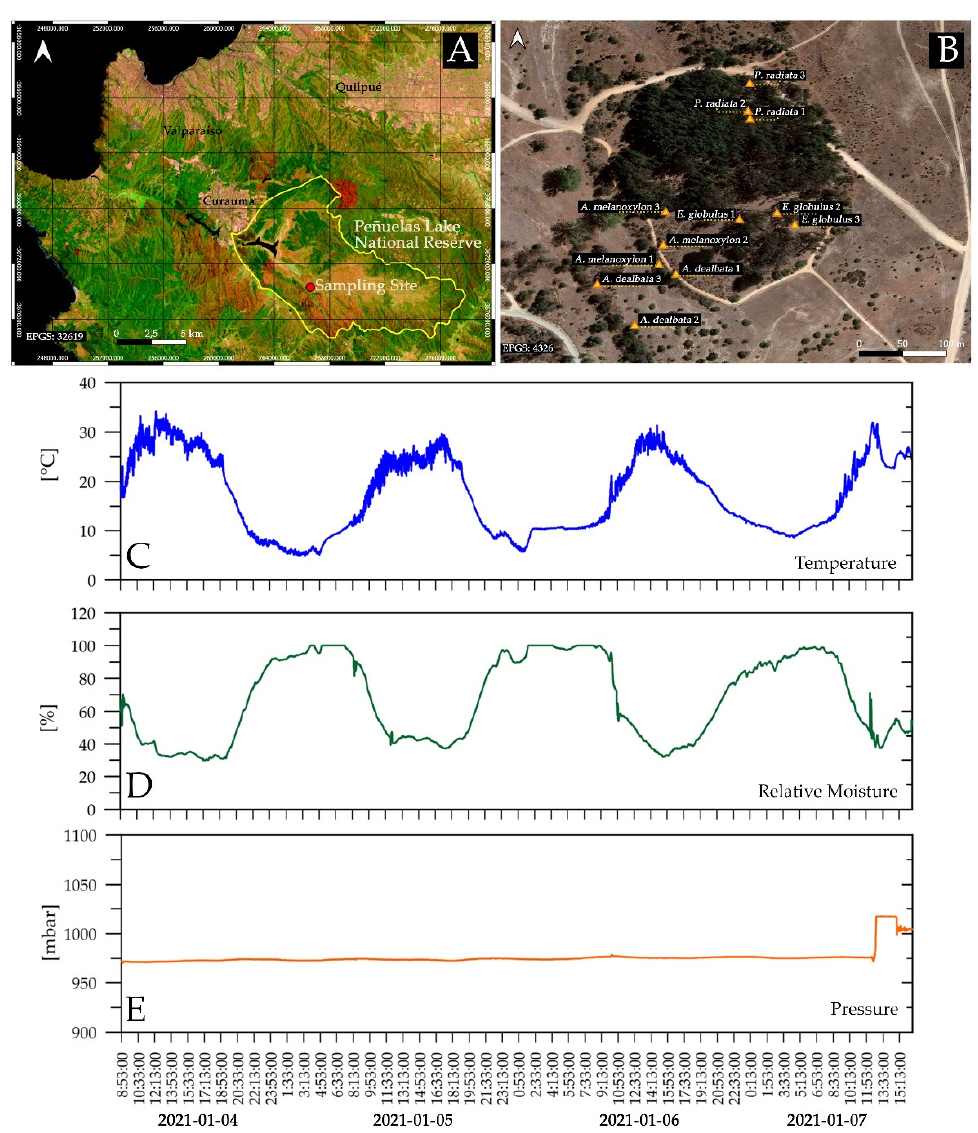
Figure 1. ( A ) Cartography of the study area and ( B ) sample site and individuals: Landsat 8 satellite image corresponding to August 24th, 2021. In this false-color composition, the short-wavelength infrared, near-infrared, and red bands are used to represent recently burnt areas in red, dense urban areas in dark shades of purple, and less dense areas in lilac. Bare soils are shown in pink to yellow, with vigorous vegetation shown in a more intense green color than non-vigorous vegetation. Average climate parameters measured with the weather meter during the sampling period: ( C ) temperature, ( D ) relative moisture, and ( E ) barometric pressure.